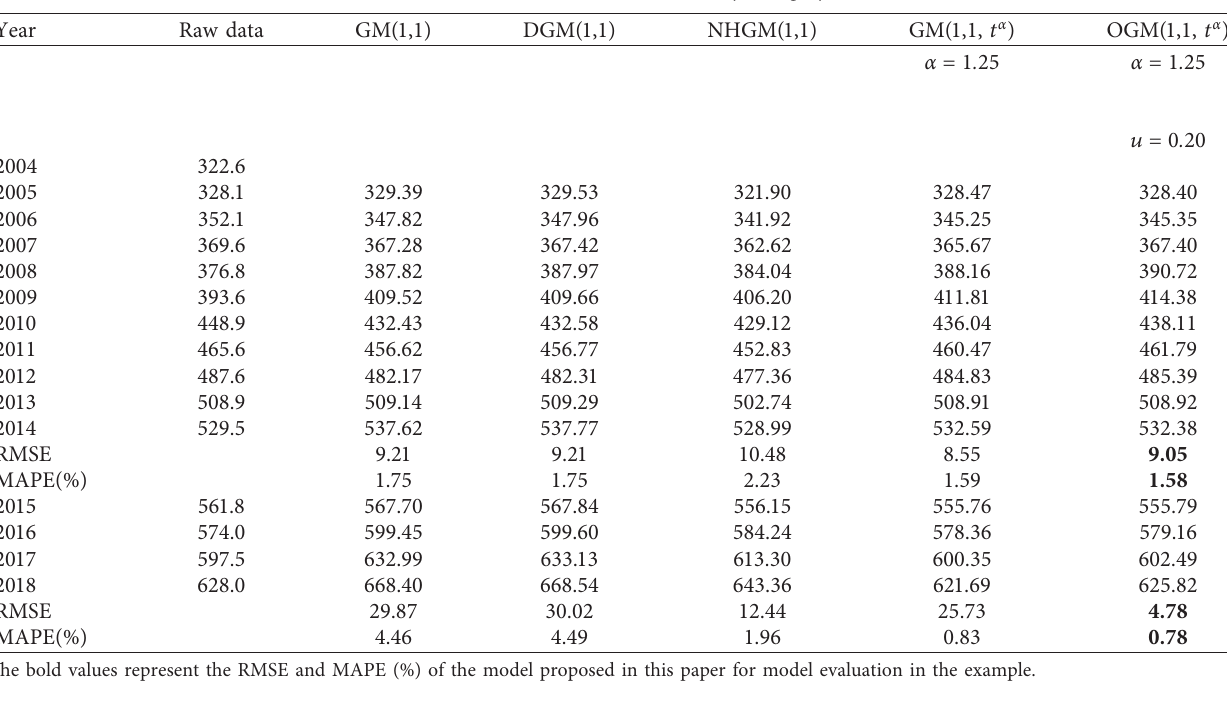
Table 4: The simulated results and indices by five grey models.